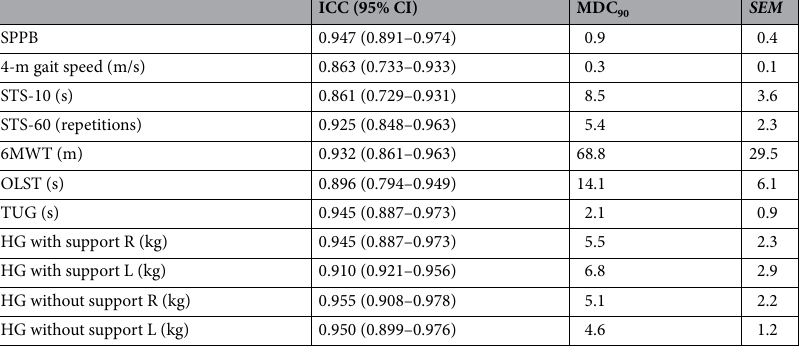
Table 3. Values of intra-rater relative and absolute reliability (haemodialysis day vs. non-haemodialysis day). n = 30. CI confidence interval, HD haemodialysis, HG handgrip strength, ICC intraclass correlation coefficient, L left side, MDC 90 minimal detectible change score 90% confidence interval, OLST one-legged stance test, R right side, SEM standard error mean, SPPB short physical performance battery, STS10 sit-to-stand 10 test, STS60 sit-to-stand 60 test, TUG timed up-and-go test, 6MWT 6-min walking